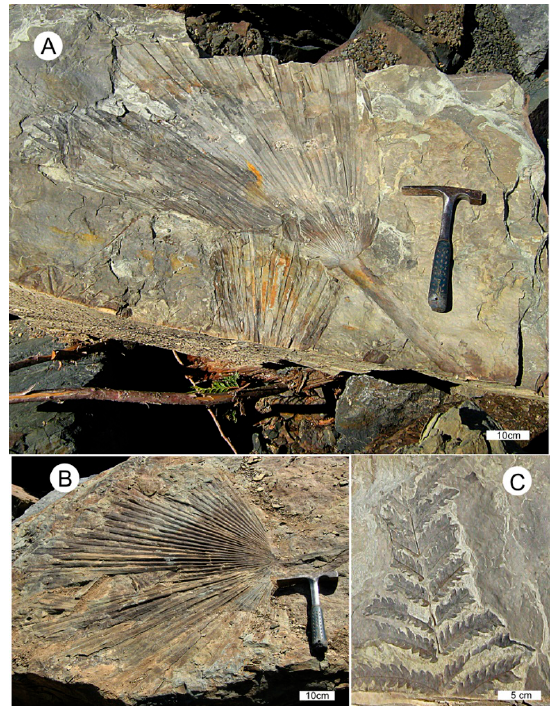
Figure 4. Semi-tropical plant fossils at Racehorse Creek landslide, WWU locality RCS-1. ( A , B ) Sabalites palm fronds; ( C ) Cyathea pinnata tree fern frond.